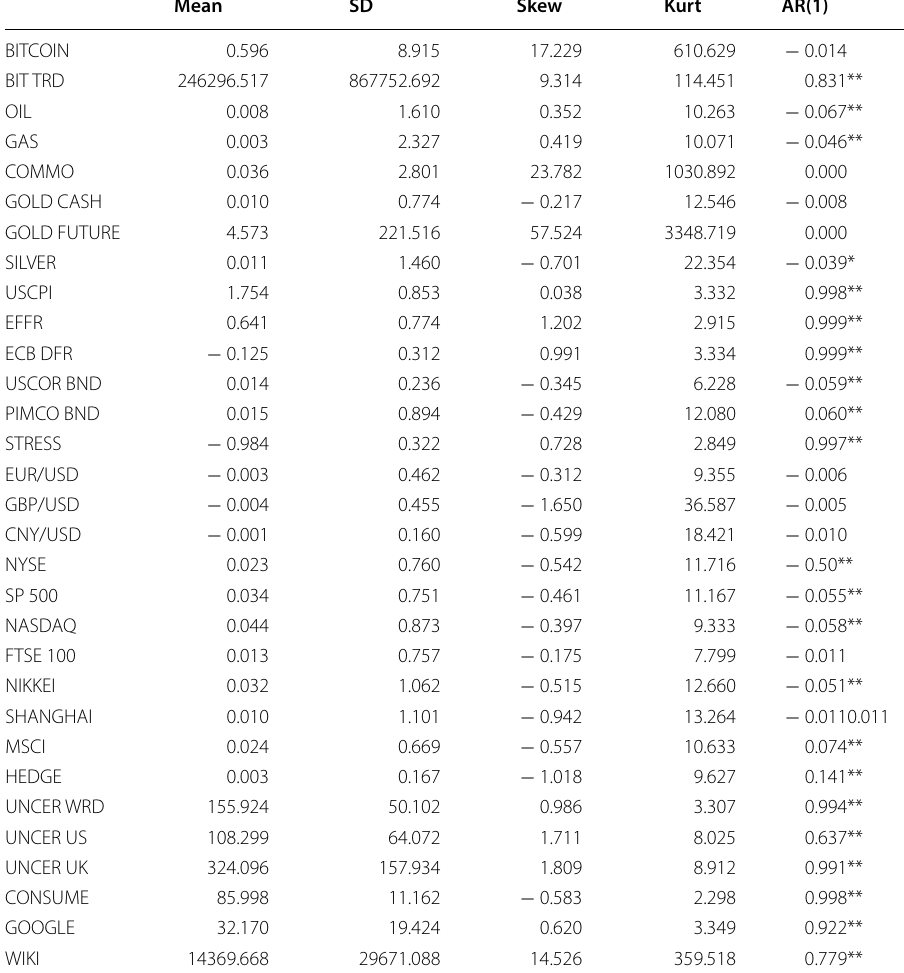
Table 2 Summary